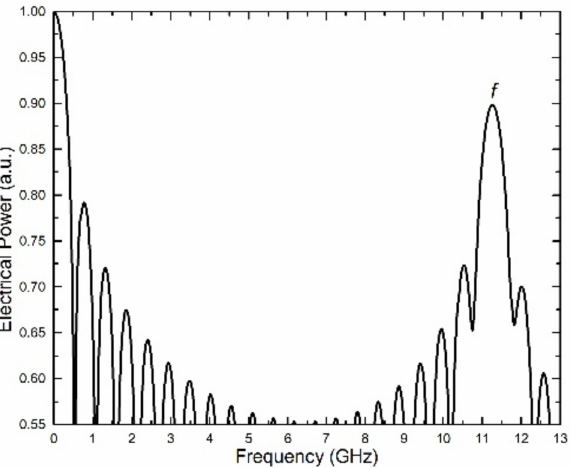
Figure 5. Simulated frequency response of the MPF corresponding to δλ = 0.40 nm